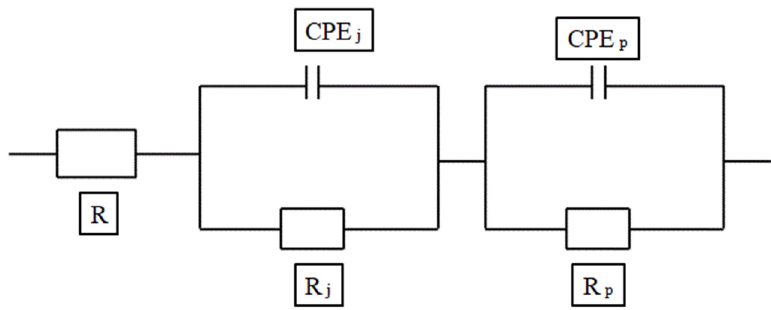
Figure 13. The circuit model for microstructural analysis.